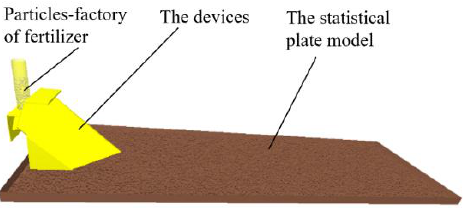
Figure 8. System model for discrete element simulation. Table 3. Test factors and levels of virtual test. Table 2. Material property parameters of the simulation model.